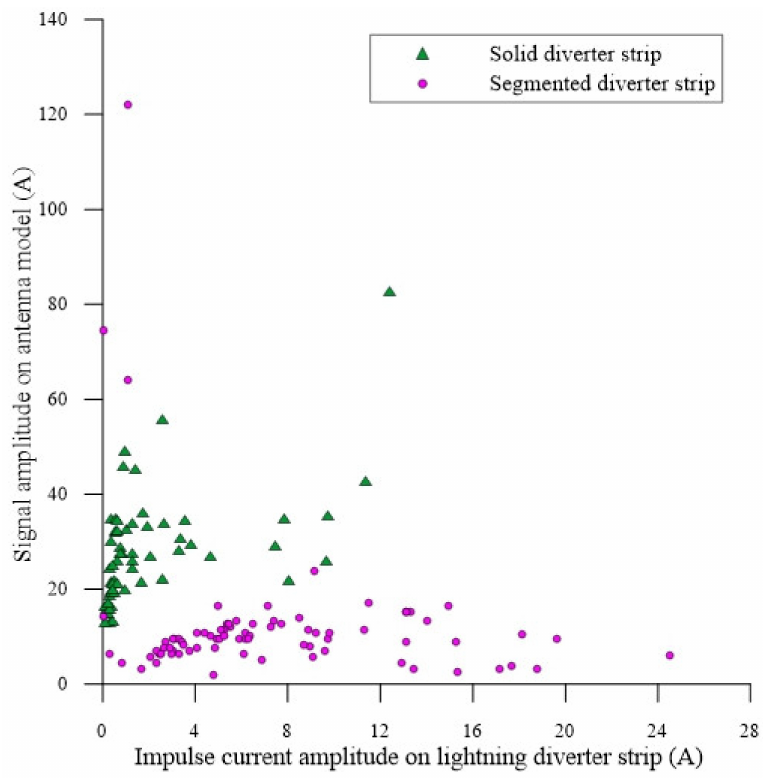
Figure 15. Dependence of the signal amplitude on the antenna on the steepness of the current impulse on the lightning diverter (types of impulses